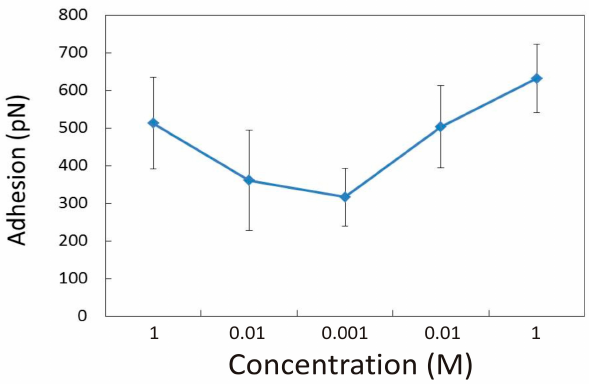
Figure 4. Graph showing the measured adhesion for experiment kao-Si-3, performed with a –COOH probe over the siloxane surface kaolinite and in the presence of CaCl 2 of various concentrations (0.001, 0.01 and 1 M) at pH = 8. Solutions were introduced in a sequence of high to low to high concentration. A drop in the measured adhesion is observed as the CaCl 2 decreases, followed by an increase as the concentration is increased again.